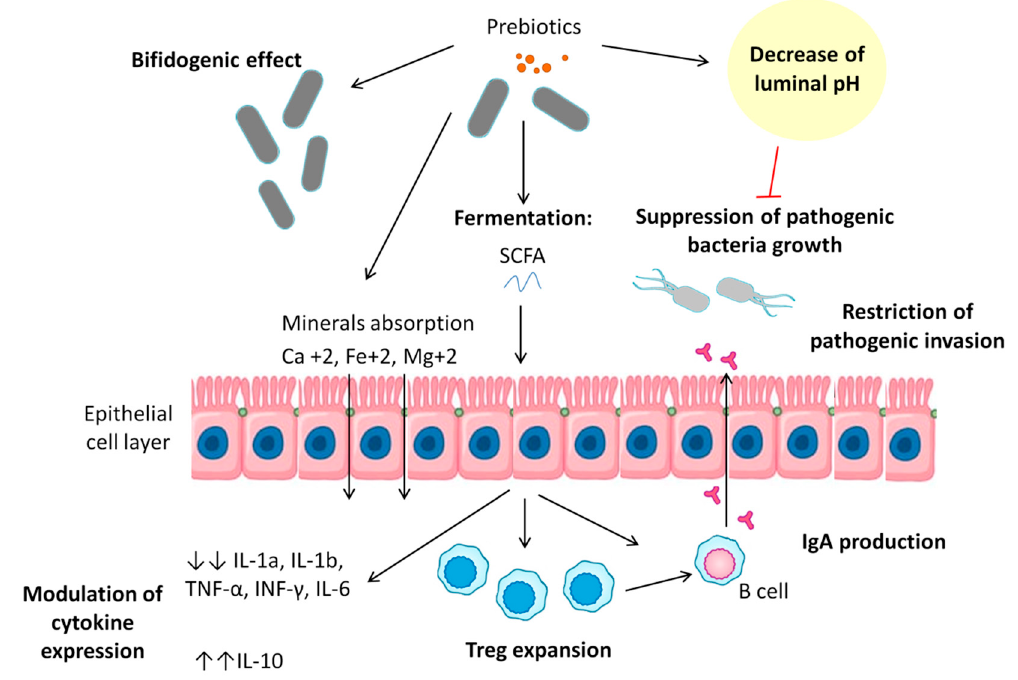
Figure 2. Mechanism of prebiotic action. These mechanisms include the production of microbial metabolic products, noting short-chain fatty acids (SCFAs), the promotion of ion and trace element absorption (such as that of calcium, iron, and magnesium), a decrease in luminal pH, and the regulation of the immune system (increasing IgA production and modulating cytokine production).